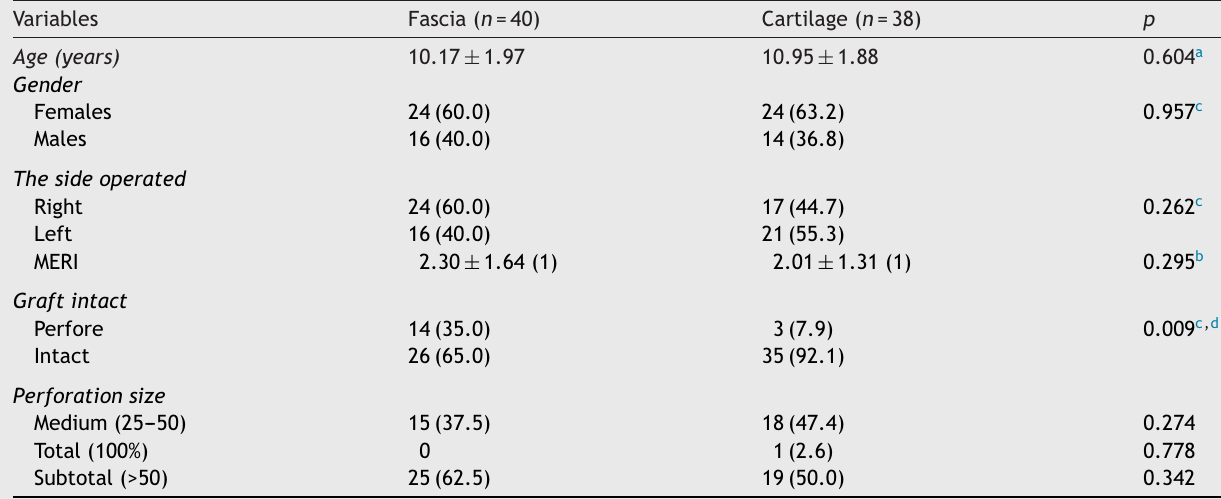
Comparison of air-bone gap and the hearing gains between the two groups pre- and postoperatively. Air bone gap